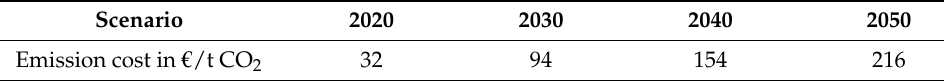
Table 2. Assumed emission certificate costs in € /t CO 2 in the scenario.